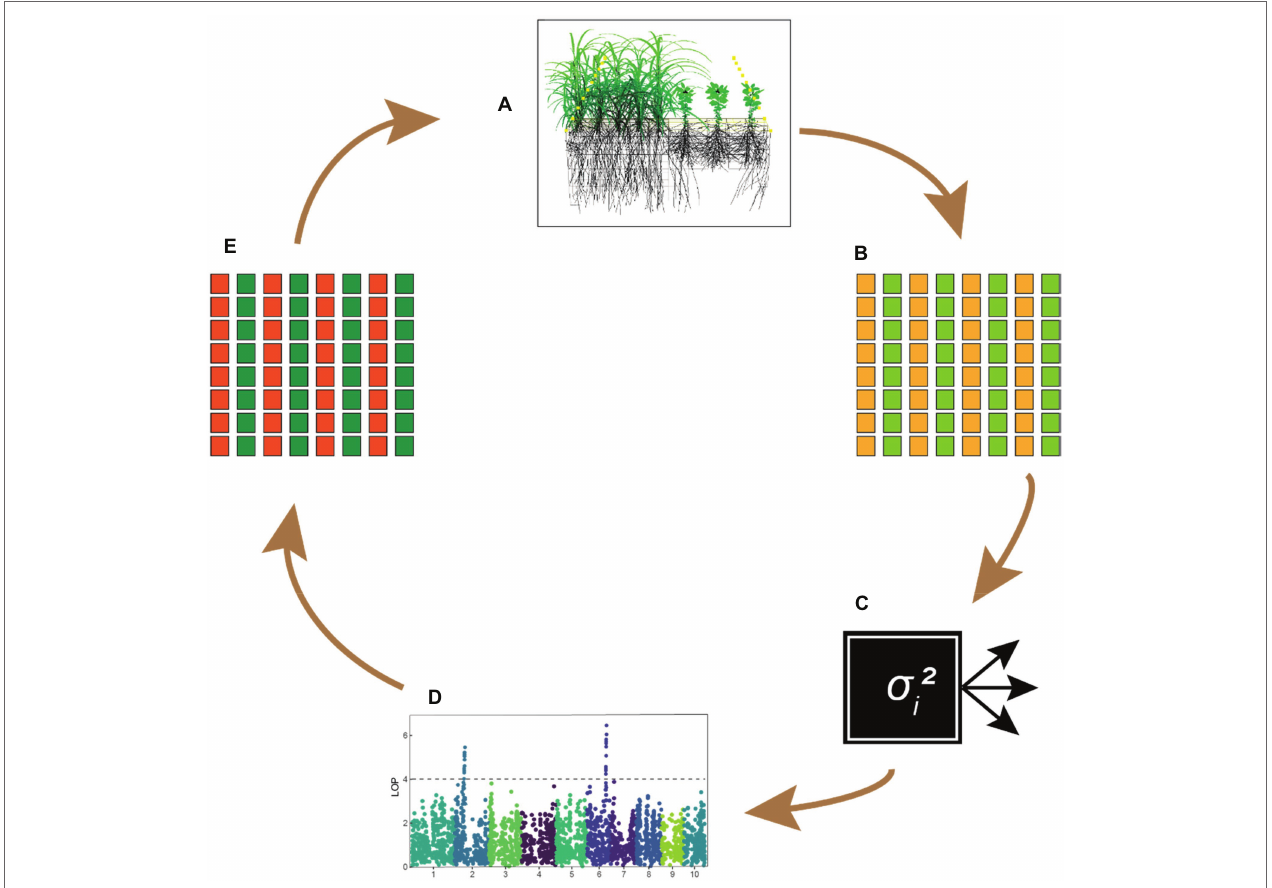
FIGURE 4 | Theoretical framework integrating FSP models with a quantitative genetics approach for intercrop breeding. (A) Functional–structural plant models can be used to test crop combinations in silico , providing hypotheses for traits that improve crop complementarity. (B) Predicted traits are tested in practice using trait- based indirect genetic effect (IGE) models. (C) Variance-component models (shown here as a black box) determine whether the effects represent a meaningful proportion of the total genetic variance. (D) Genome-wide associations studies may reveal whether any major loci underlie differences in intercrop performance, to be used as fixed effects in a genomic prediction model. (E) Superior-performing genotypes are combined in further field trials, providing new data to update FSP models. This refinement step will lead to a new set of hypotheses on complementarity traits, renewing the